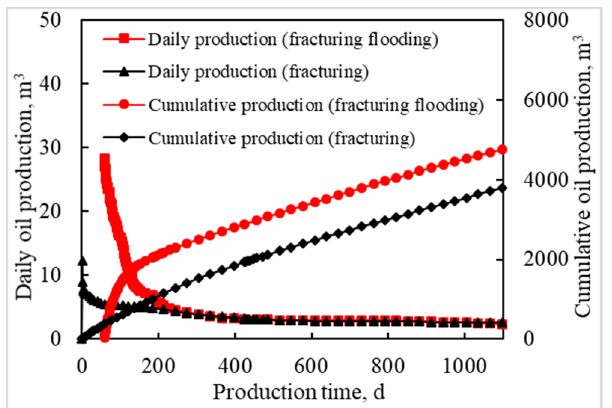
Figure 12. Comparison between fracturing flooding and conventional fracturing.